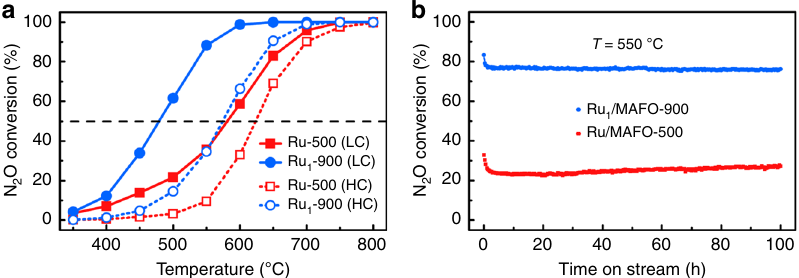
Fig. 3 Catalytic performance of Ru/MAFO samples for N 2 O decomposition. a N 2 O conversion as a function of reaction temperature on Ru/MAFO samples at low (1000 ppm N 2 O, solid symbol) and high (20 vol% N 2 O, open symbol) concentrations. Reaction conditions: 100 mg catalyst; gas fl ow, 33.3 mL min − 1 ; GHSV = 20,000mL g cat − 1 h − 1 ; Ar balance. b N 2 O conversion as a function of reaction time on Ru/MAFO samples in low-concentration N 2 O decomposition tested at 550 °C. Reaction conditions: 100 mg catalyst; gas fl ow, 33.3 mL min − 1 ; GHSV = 20,000 mL g cat − 1 h − 1